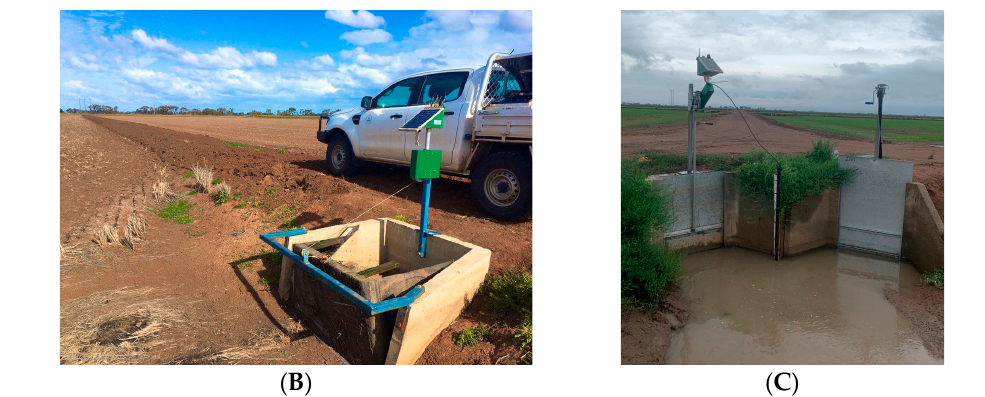
Figure 2. Automation infrastructure used at Site B. ( A ) Manually controlled pre-existing rubber lay- flat outlet (open). ( B ) AutowinchSense installed to pre-existing rubber lay-flat (closed). ( C ) AutowinchSense installed on sluice gate to automated field with manual winch on the manually irrigated field (both closed).